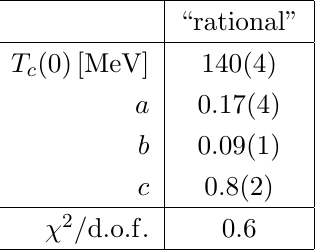
Table 2 . The parameters of a (cid:12)t to the T c ( m ) data using the function of eq. (4.1).